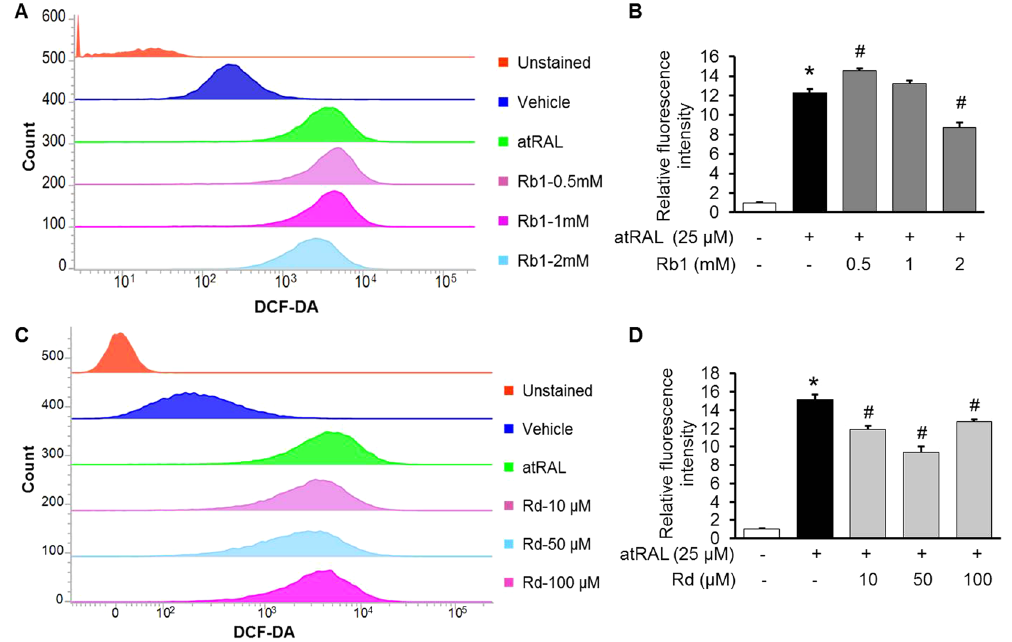
Figure 7. Rb1 or Rd treatment decreased atRAL-induced intracellular ROS production in ARPE19 cells. ARPE19 cells were treated with vehicle (saline or DMSO), Rb1 or Rd at the indicated concentrations for 1 h before being exposed to atRAL at 25 μ M for 5 h, followed by DCF-DA staining for 30 min. After DCF-DA staining and washing, cells were resuspended and subject to further analysis by flow cytometry at the excitation and emission wavelengths of 490 nm and 520 nm, respectively. For each sample, 20,000 cells were acquired for data collection. Representative histograms of flow cytometry after DCF-DA staining were shown in ( A , C ). Relative DCF-DA fluorescence intensity was calculated against that from vehicle-treated cells without atRAL exposure (n = 4–5 per group) ( B , D ). The data were expressed as the mean ± S.E.M. * Compared to that from vehicle-treated cells unexposed to atRAL, p < 0.05; # compared to that from atRAL-challenged vehicle-treated cells, p <